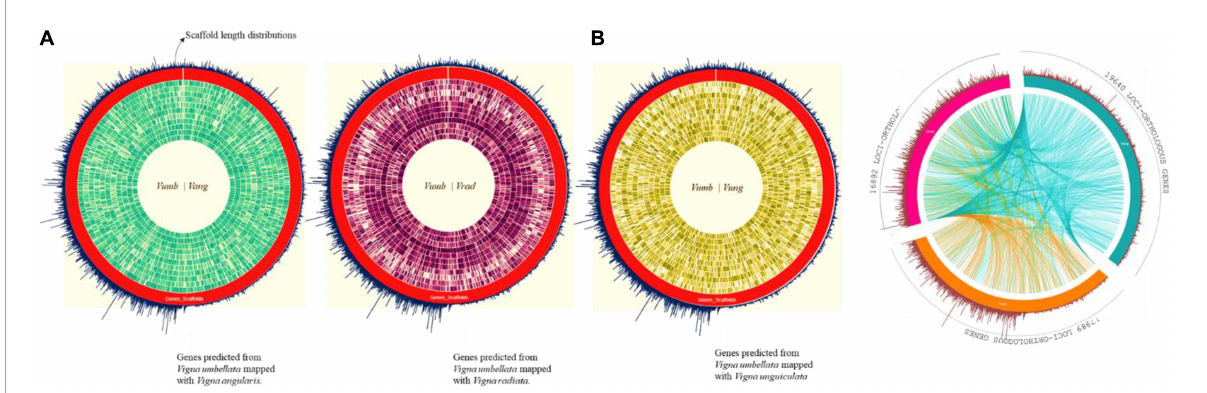
FIGURE2 (A) Complete predicted genes Vigna umbellata mapped for Chromosomal-specific comparison for the proximity of gene scaffold mapping to its reference. (i) Rice bean mapped syntenic region average of 82% spanned for its gene specificity with adzuki bean. (ii) Rice bean with mung bean having relation of each chromosomes of about 72%. (iii) Rice with cowpea mapping found 62% of functional clusters with micro break from its evolution. (B) Orthologous synteny gene map comparison between adzuki bean, mung bean, and cowpea with genes mapped from assembly. Green color is adzuki bean mapping with 19,640 loci, orange colored mung bean mapping; 17,989 loci, and 16,892 loci for cowpea- pink